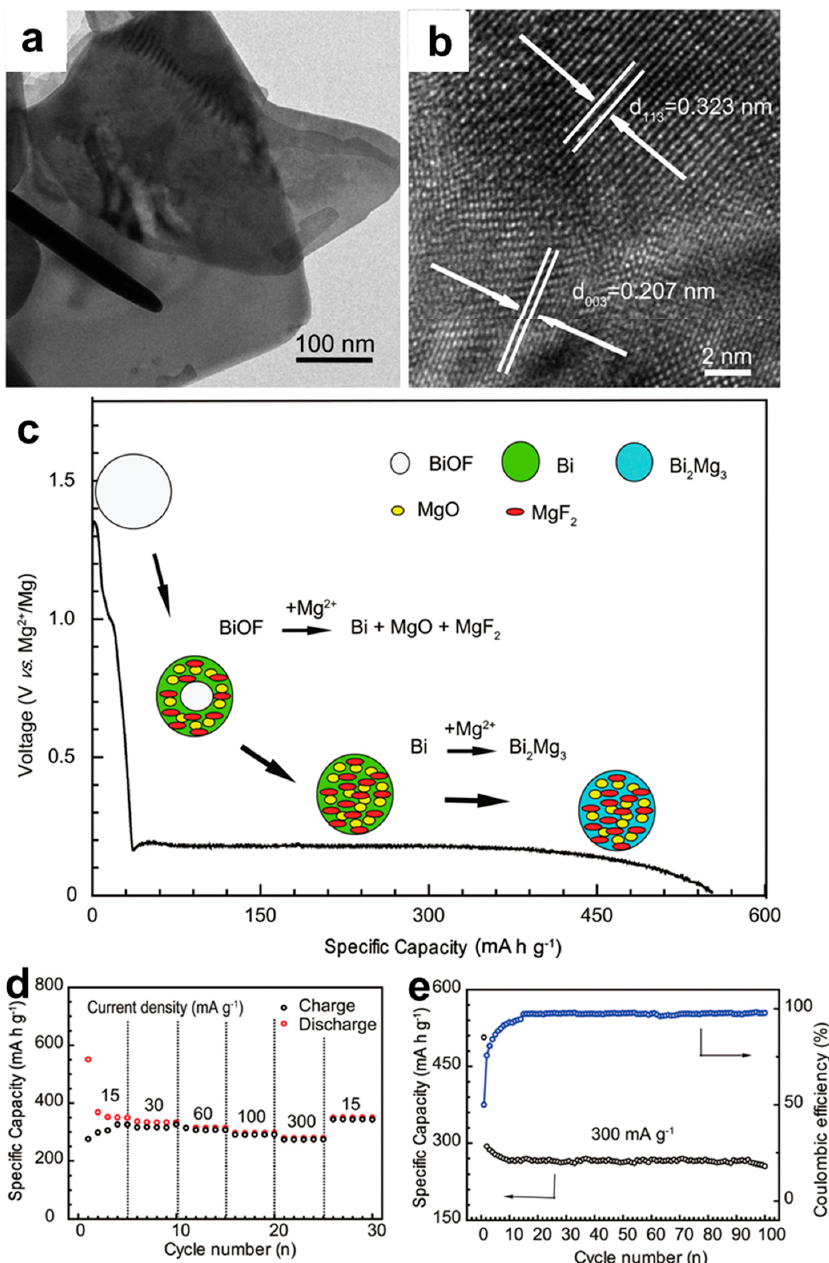
Figure 5. ( a ) TEM and ( b ) HRTEM images of the BiOF nanosheets. ( c ) The schematic illustration of the phase evolution reaction during the discharge process. ( d ) The rate performance and ( e ) cycling stability of the cells using the BiOF electrodes. Reproduced with permission [31]. Copyright 2018, The Royal Society of Chemistry.